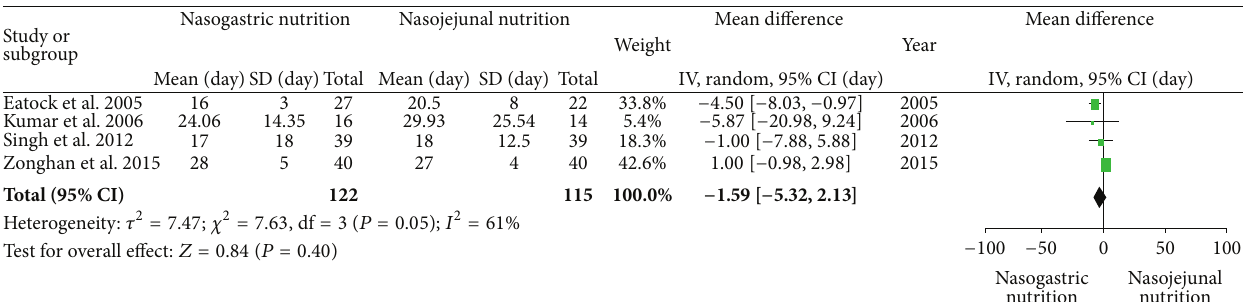
Figure 7: Comparison of the lengths of hospital stay between the NG nutrition and NJ nutrition groups.